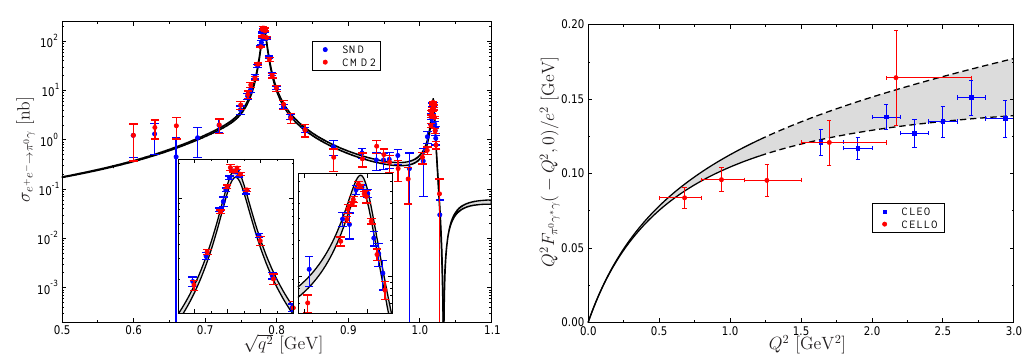
π 0 γ cross section predicted from e + e − Figure 3. Left panel: e + e − → 35]. Right panel: Singly-virtual pion transition form factor in the space-like region, compared to CELLO [36] and CLEO [37] data. Figures taken from Ref.